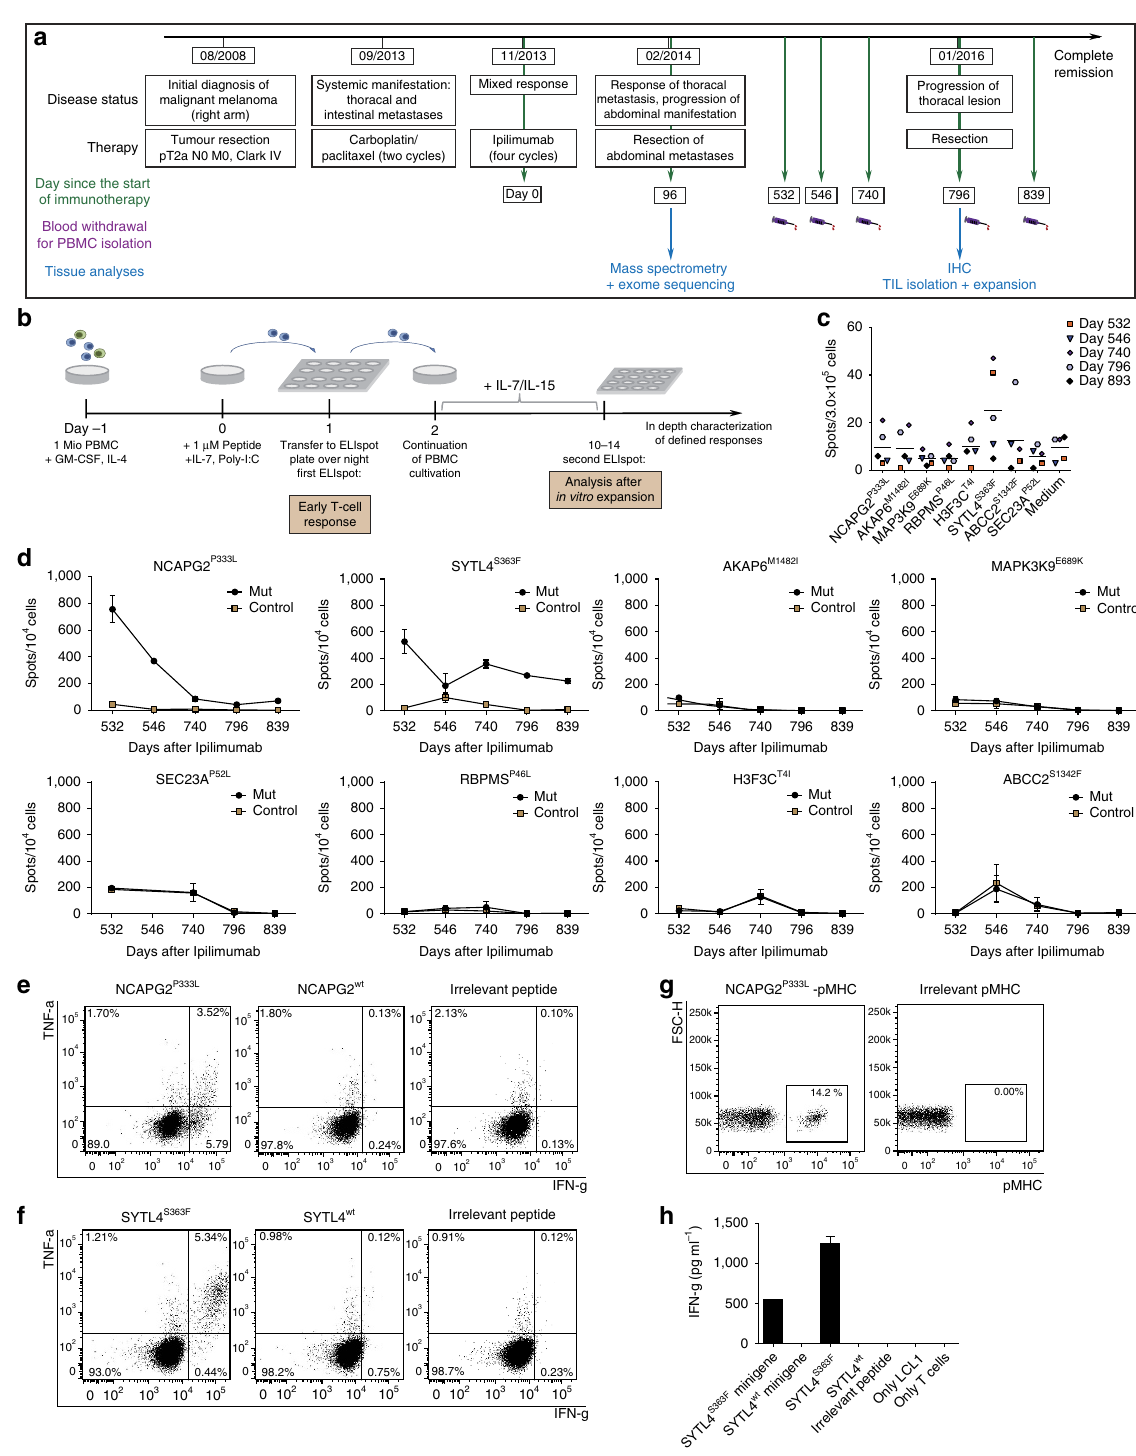
Figure 5 | Immune responses against mutated ligands in PBMC of patient Mel15. Clinical course and retrieval of patient material ( a ). Schematic overview of the experimental design of recall immune responses among blood-derived T cells from patient Mel15 ( b ). Early immune responses detected in PBMC derived from different blood withdrawals two days after in-vitro peptide stimulation ( c ). Time course of specific reactivities of blood-derived PBMC obtained at different time points against the eight identified mutated epitopes from patient Mel15. All analyses were performed in duplicates and spot counts were adjusted to 10 4 cells ( d ). Intracellular cytokine staining (ICS) of an expanded NCAPG2 P333L specific T-cell line from day 546 (PBMC- NCAPG2-546) after co-incubation with peptide pulsed T2-A3 target cells for 5h ( e ). ICS of T-cell line PBMC-SYTL4-740 stimulated with SYTL4 S363F from day 740 after co-culture with peptide pulsed T2-B27 target cells ( f ). Staining of line PBMC-NCAPG2-546 with the specific multimer in comparison to irrelevant multimer staining ( g ) IFN-g secretion after coincubation of T-cell clone PBMC-SYTL4clone1 derived from line PBMC-SYTL4-740 with peptide pulsed and minigene-transduced LCL1 (results of triplicates) ( h ). Data from experiments with triplicates are shown as mean ± s.d., data resulting from duplicates are shown as mean. NATURE COMMUNICATIONS|7:13404|DOI: